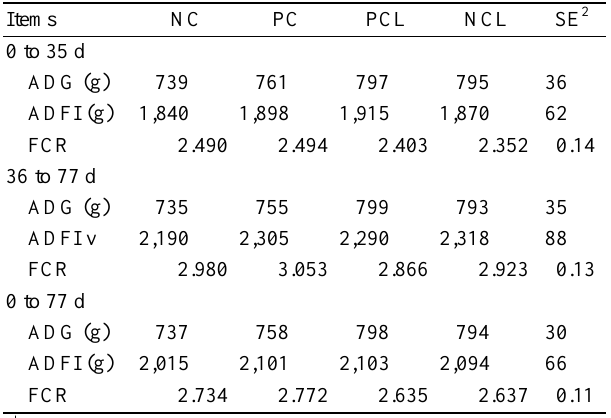
Table 2. Effect of low fermentable carbohydrates (FC) on growth